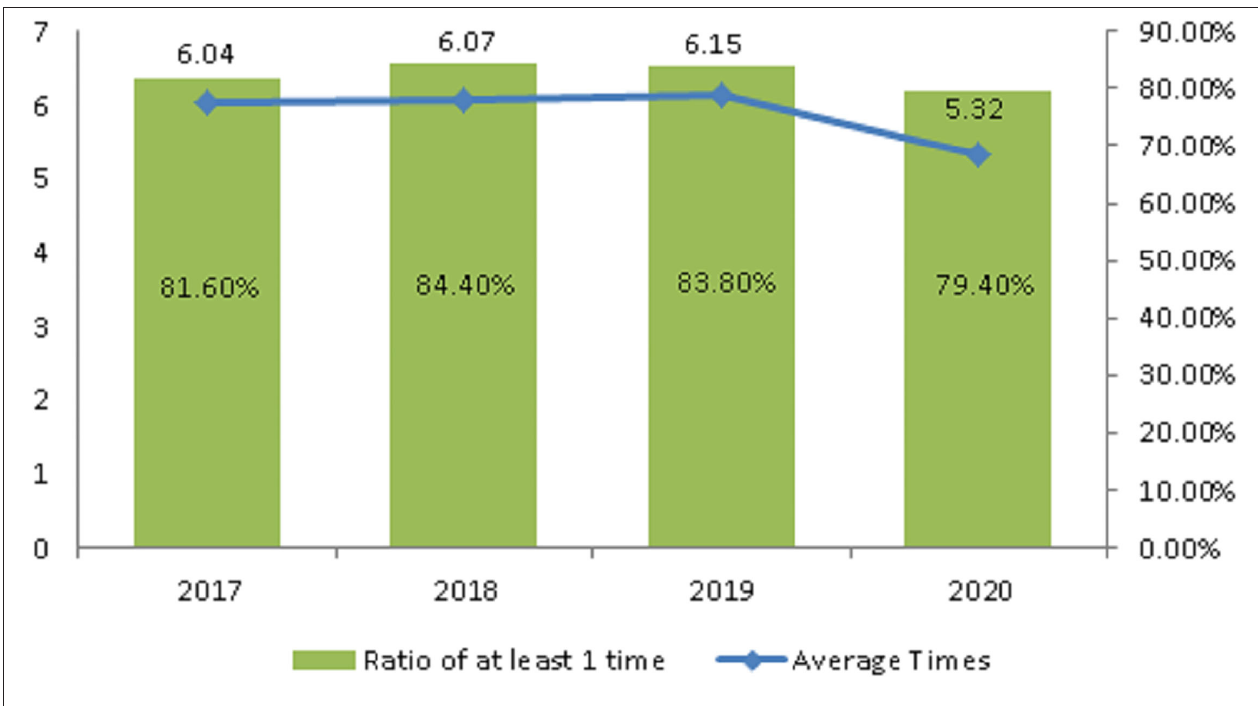
FIGURE 1 | The trend of tourism frequency.